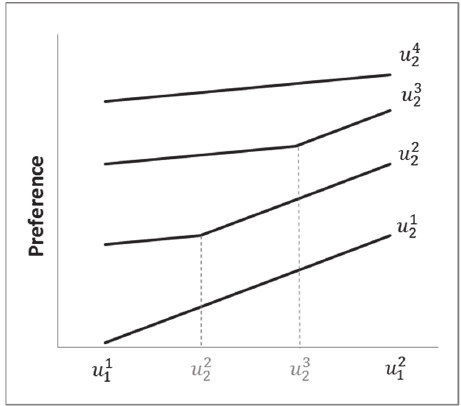
Fig. 4. Preference lines for the cases discussed in Section